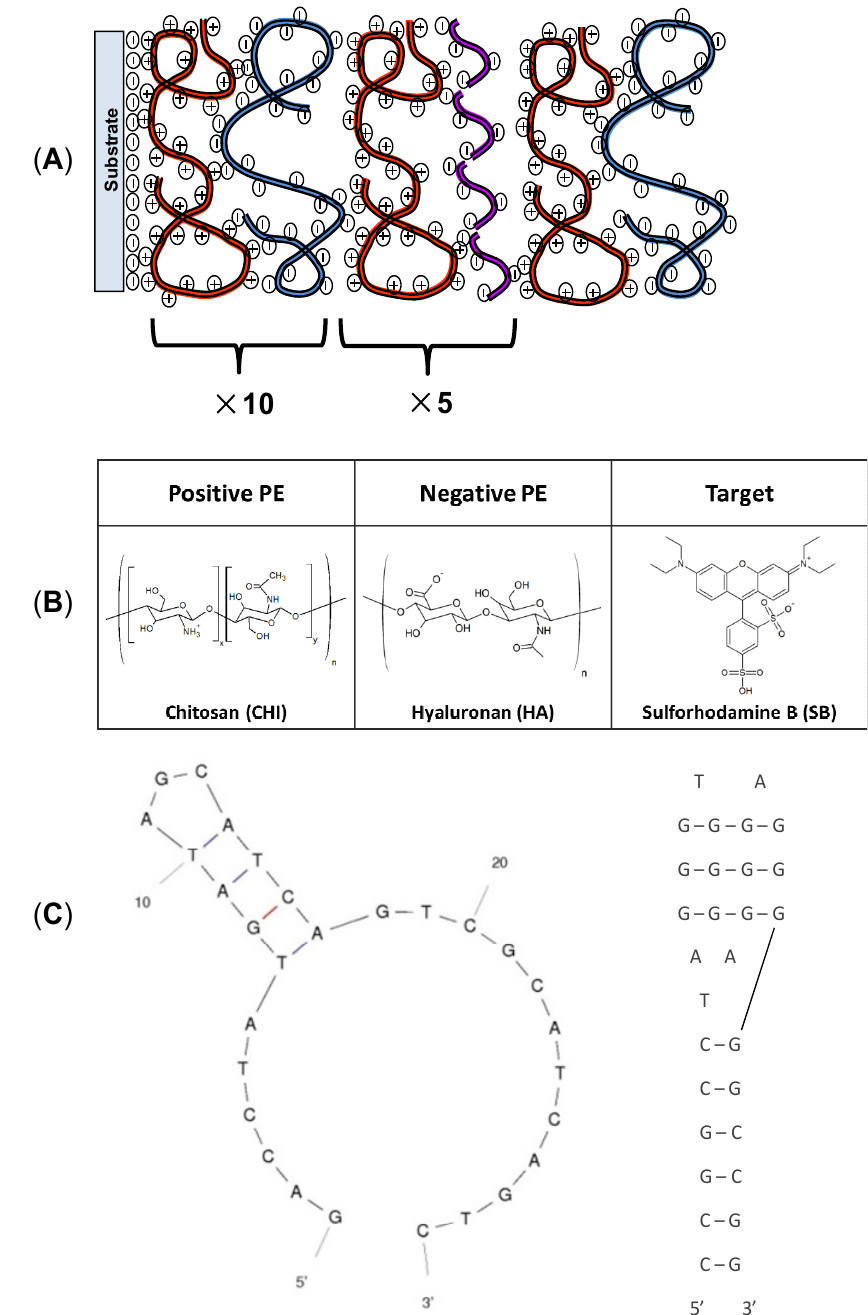
Figure 1. Overview of multilayer film composition. ( A ) Schematic of optimized CHI/HA/DNA film. Ten bilayers of chitosan (CHI) (red) and hyaluronan (HA) (blue) compose the base of the film. Five bilayers composed of CHI and DNA (pink) compose the DNA layers of the film. DNA can represent the incorporation of the sulforhodamine B aptamer (SA) or the 29-nt RO. The film then topped with a single bilayer of CHI and HA (capping layer). ( B ) Monomer structures of the polyelectrolytes (PEs) used in the film and structure of the target dye SB. ( C ) Sequences of RO (left) and SA (right). Sequences are shown in their predicted secondary structures: a hairpin-loop (RO) (computed by Mfold) and a G -quadruplex (SA) (Adapted from